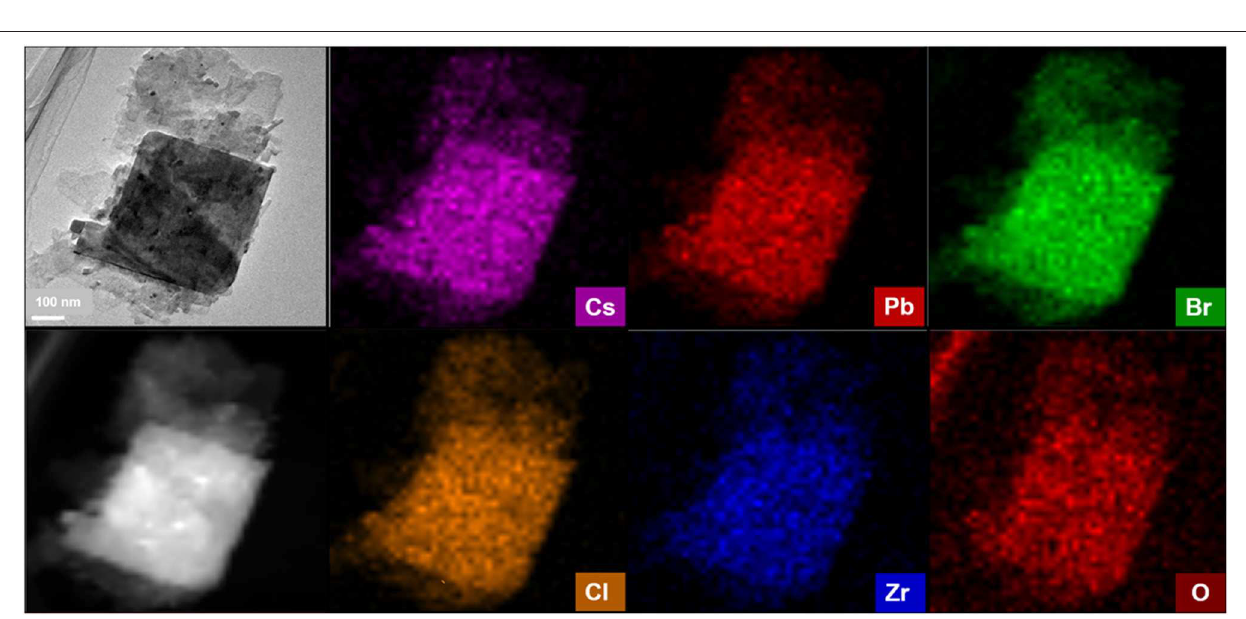
FIGURE 4 | HAADF-STEM image of CPB-Zr-0.75 and the corresponding EDS elemental mapping of Cs, Pb, Br, Cl, Zr, and O in the same